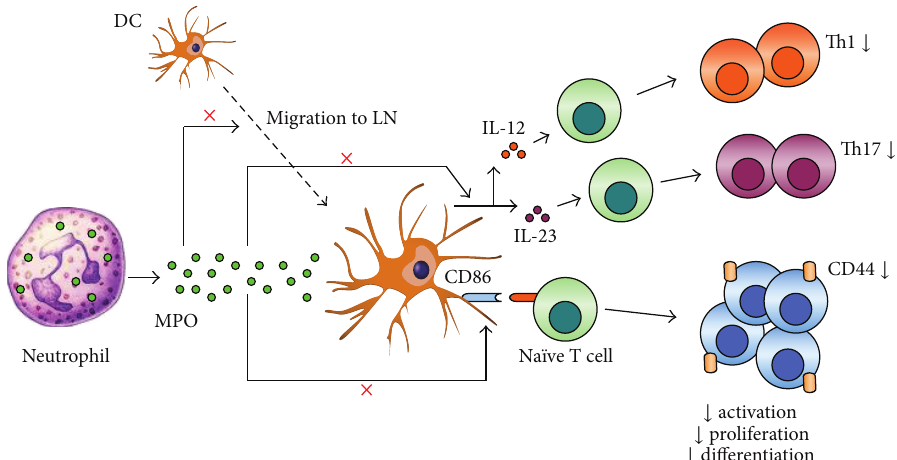
Figure 2: Neutrophil MPO suppresses DC function and adaptive immunity . Odobasic et al. [21] showed that rapidly infiltrating neutrophils release MPO in draining lymph nodes (LN) after antigen/adjuvant injection. The deposited MPO suppresses various aspects of DC function including costimulatory molecule (e.g., CD86) expression and cytokine (IL-12, IL-23) production and migration, resulting in decreased generationofCD4TcellresponsesincludingTcellactivation(CD44expression),proliferation,anddifferentiationintoTh1(IFN 𝛾 -producing) and Th17 (IL-17A-releasing)